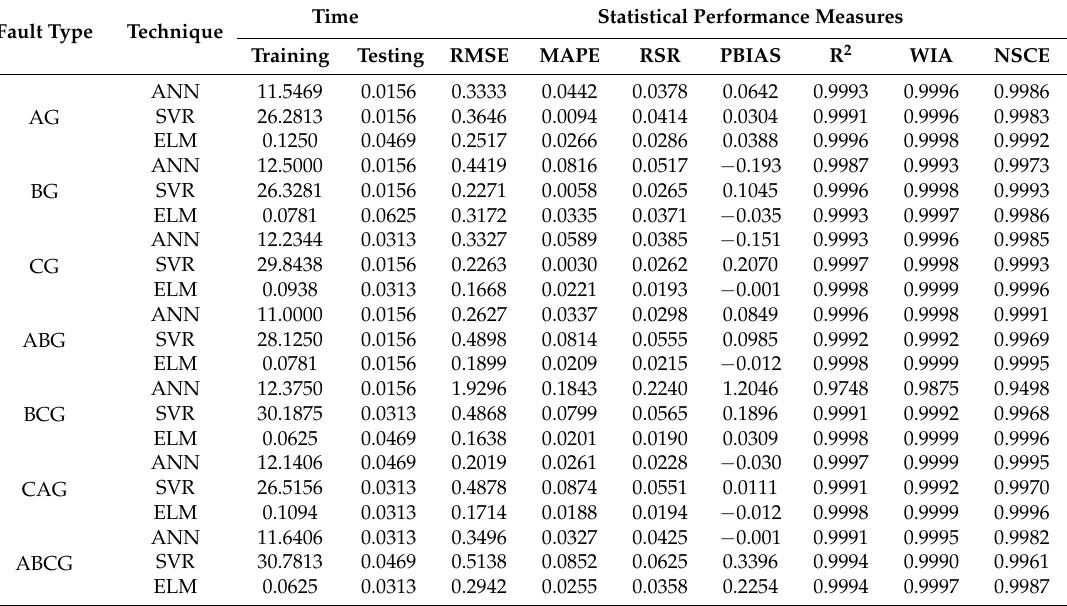
Table 6. Operation time and statistical performance indices for test datasets with CF-PSO optimized MLT